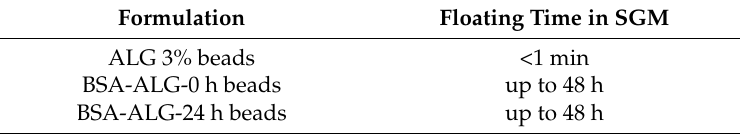
Table 1. Floating time of gastroretentive beads in the simulated gastric medium (SGM).